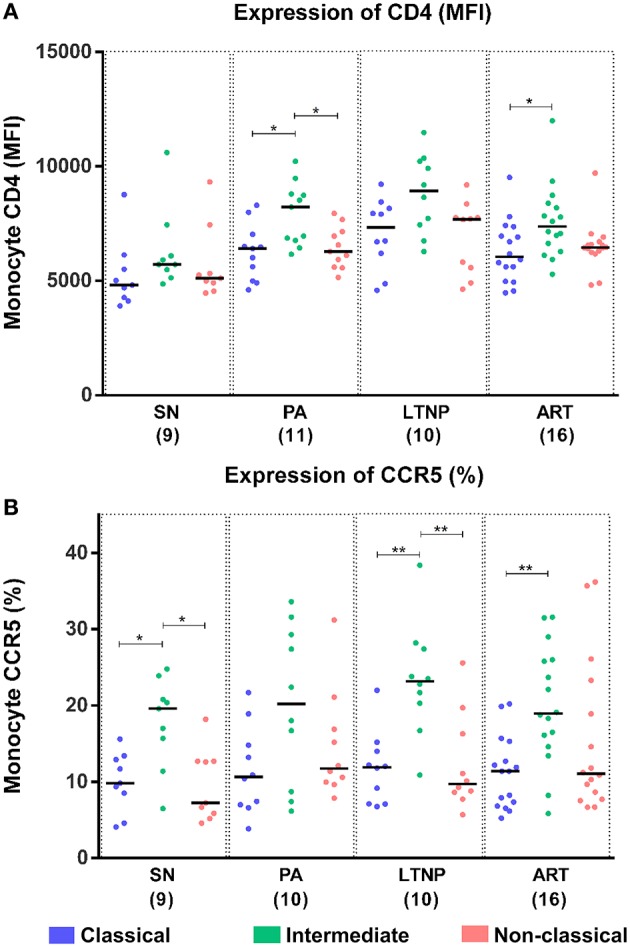
Differential expression of HIV-binding receptors on monocyte subsets. (A) Per-cell expression of HIV-binding receptor CD4 (MFI) was highest on the intermediate monocyte subset across cohorts. Kruskal-Wallis ANOVA followed by Dunn's multiple comparison test was used to assess significance. Although not significant by ANOVA, per-cell expression of CD4 was observed to be significantly higher on intermediate monocytes in the LTNP group using unpaired t-test (P < 0.05 for both classical and non-classical subsets). (B) Expression of HIV co-receptor CCR5 (% positivity) was highest on intermediate monocytes across different disease progression states. The plot reflects results of Kruskal-Wallis ANOVA followed by Dunn's multiple comparison test to assess significance; *P < 0.05; **P < 0.01.